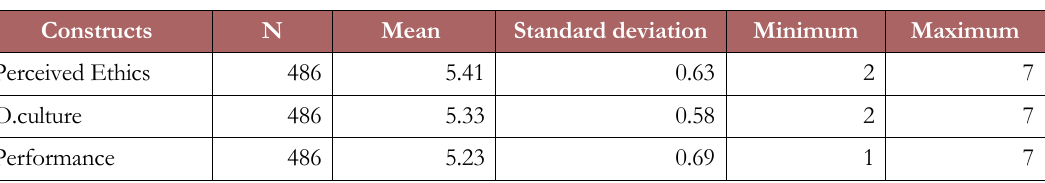
Table 2. Descriptive